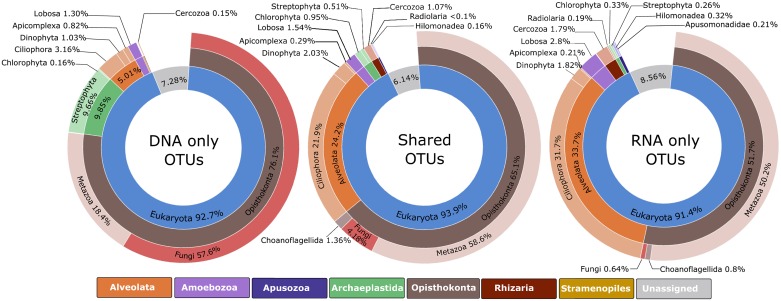
Global biodiversity of Operational Taxonomic Units (OTUs) for the DNA-only, shared eDNA/eRNA, and RNA-only datasets.The charts show the relative abundance of sequences at highest assigned taxonomic levels.